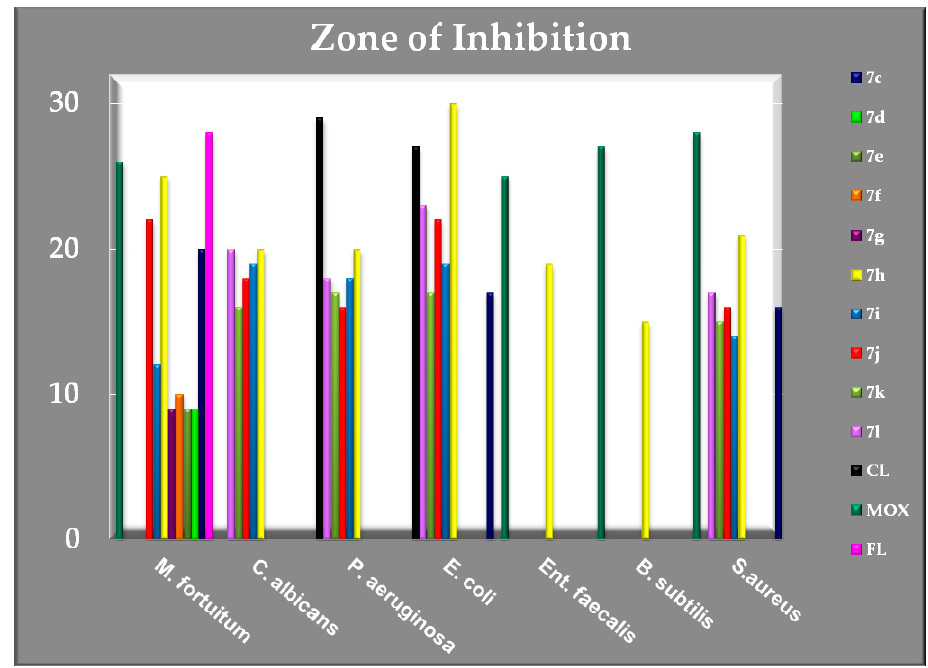
Figure 3. Graphical representation of the zone of inhibition (mm) of the compounds ( 7c – l ) and reference antimicrobial drugs against different bacterial and fungal strains.